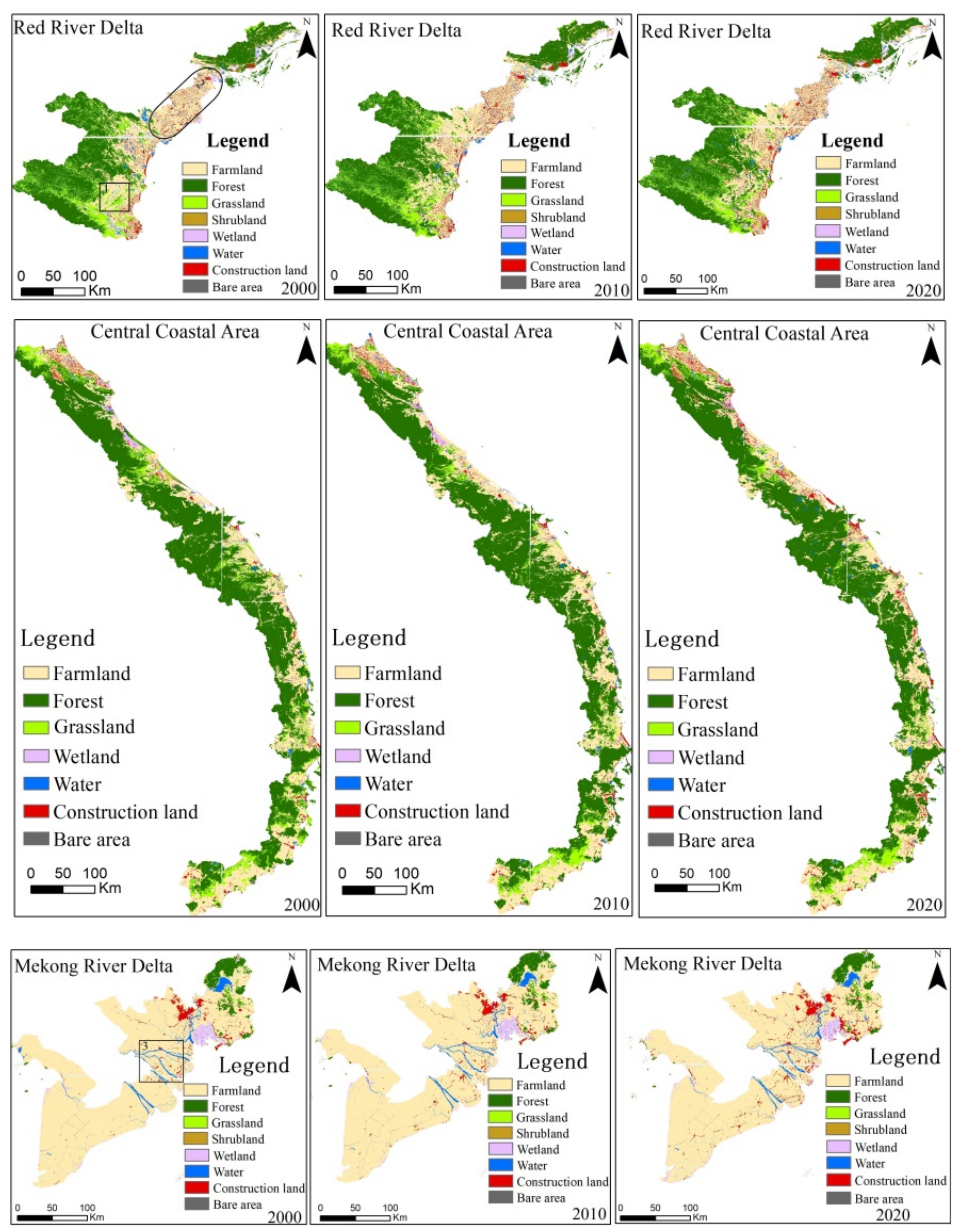
Figure 6. The land use change of subregions in 2000–2020.